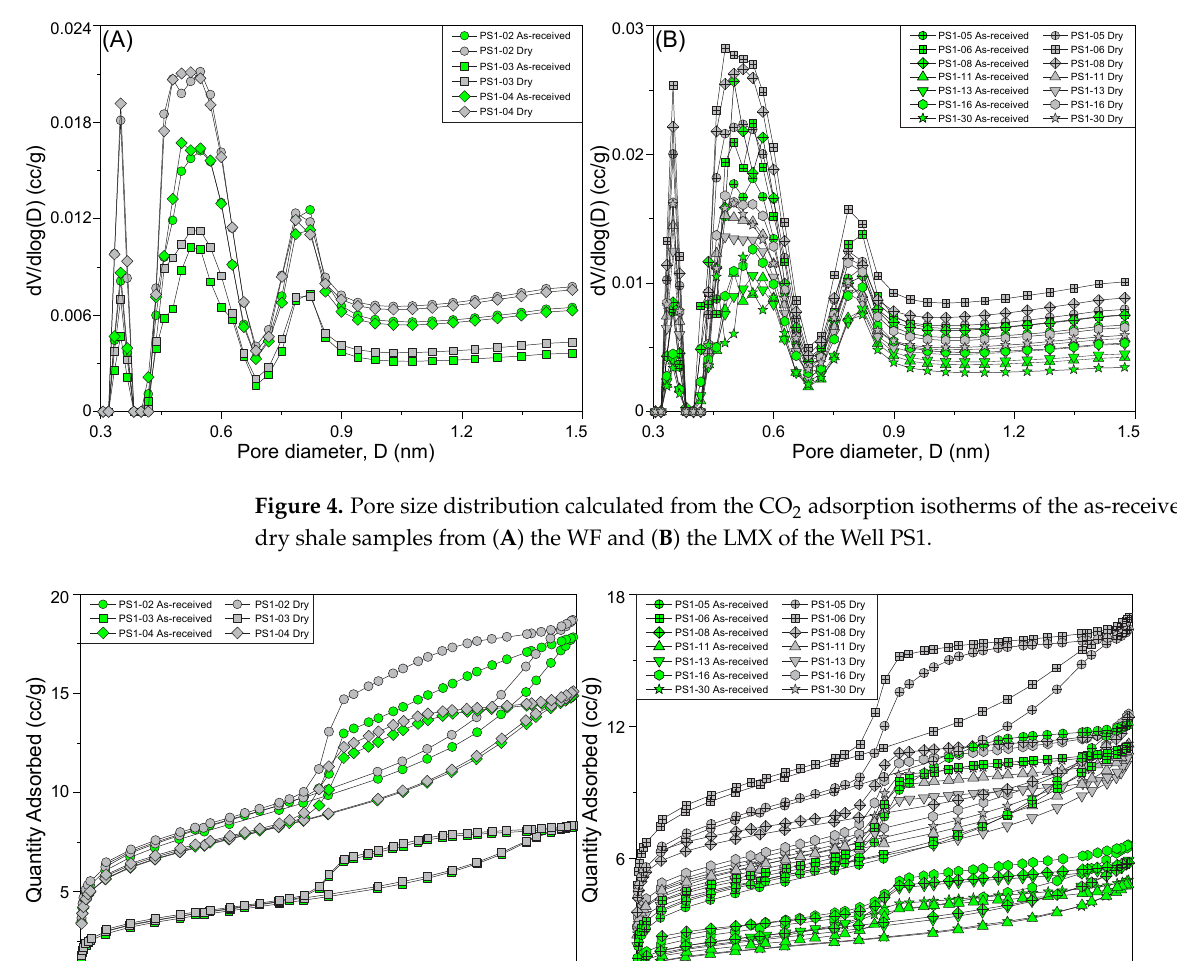
Figure 4. Pore size distribution calculated from the CO 2 adsorption isotherms of the as-received and dry shale samples from ( A ) the WF and ( B ) the LMX of the Well PS1.